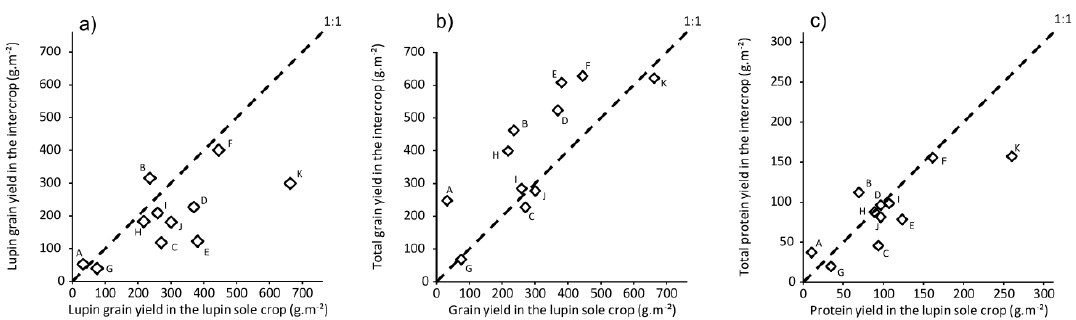
Figure 8. ( a ) Lupin grain yield in the intercrop against lupin grain yield in the lupin sole crop. ( b ) Total grain yield in the intercrop against lupin grain yield in the lupin sole crop. ( c ) Total protein yield in the intercrop against protein grain yield in the lupin sole crop. Letters next to points identify study sites. The dashed lines represent the theoretical situations with equal values in both cropping strategies.